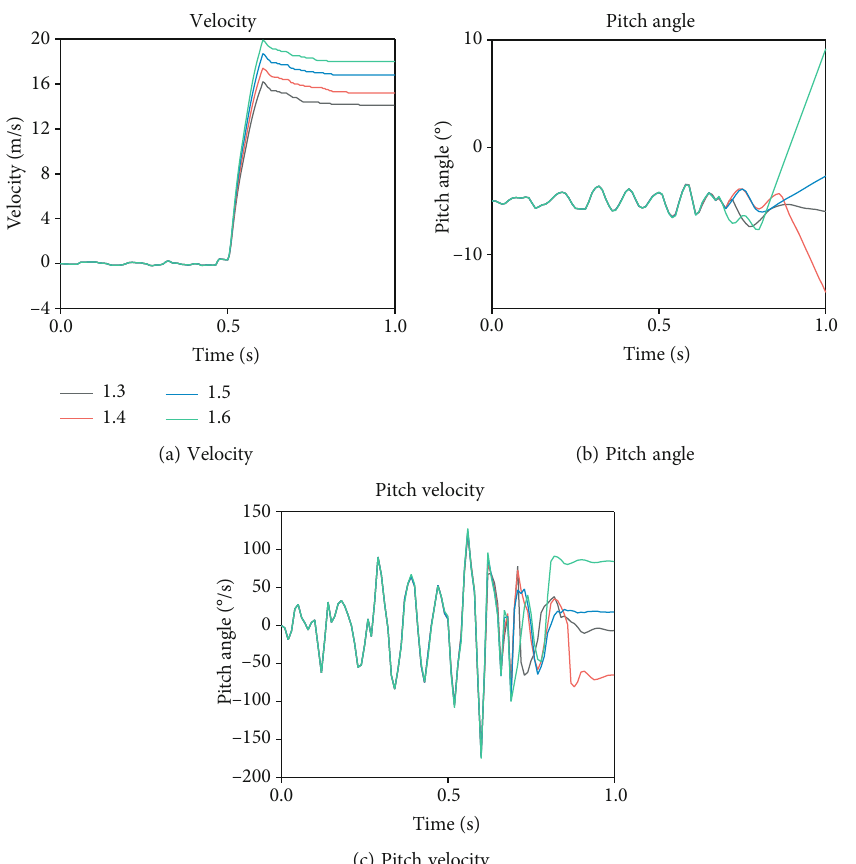
Figure 12: Comparison of missile movement with airborne